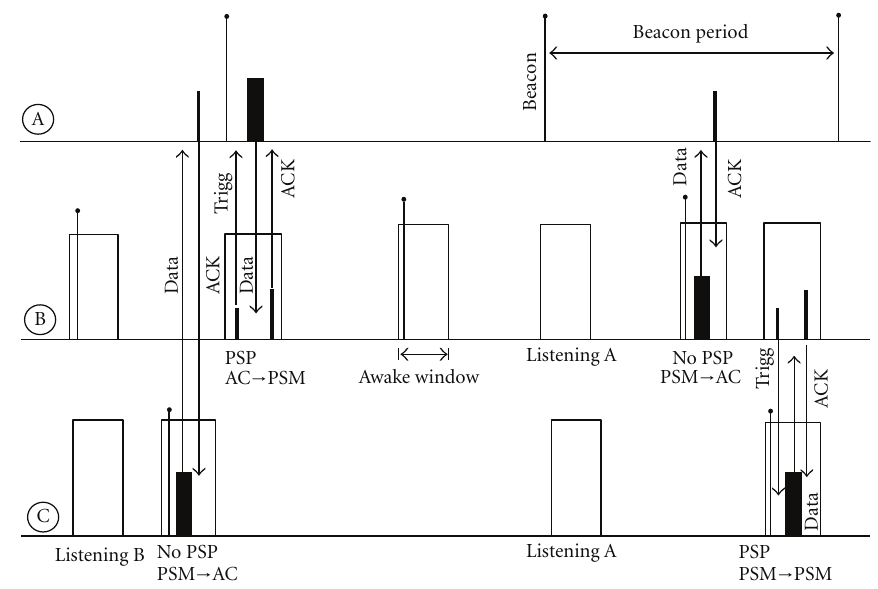
Figure 2: The internal states of mesh STAs during frame transmission and reception. A is in active mode. B and C are in PSM. STA’s power modes to links are given in Figure 1.